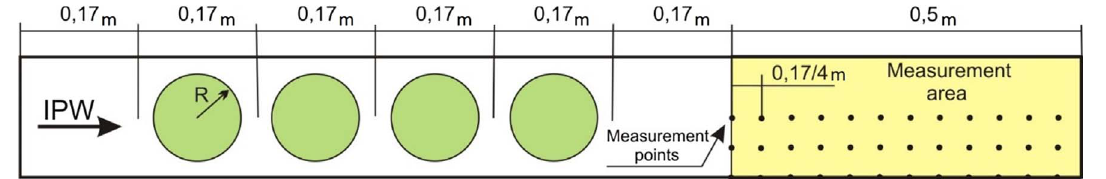
Figure 1. Schematic representation of the system con fi guration used in the